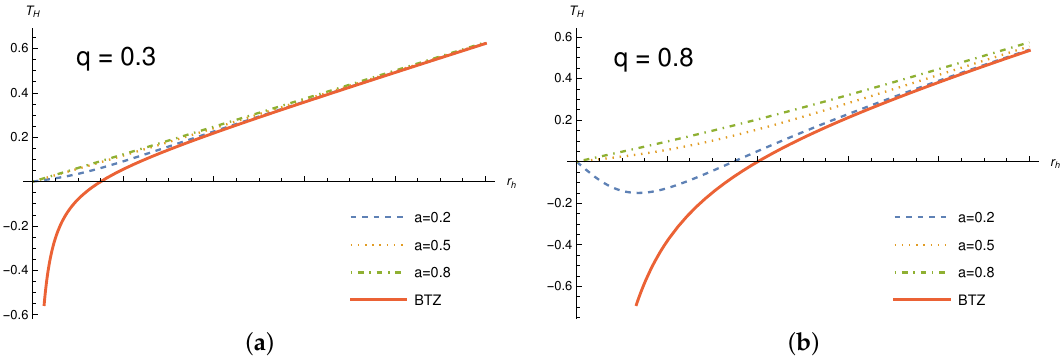
Figure 7. Plot of the Hawking temperature for the Simpson–Visser charged BTZ black hole. We used for this plot M = 1 and l = 0.5. ( a ) stands for q = 0.3 and ( b ) stands for q =